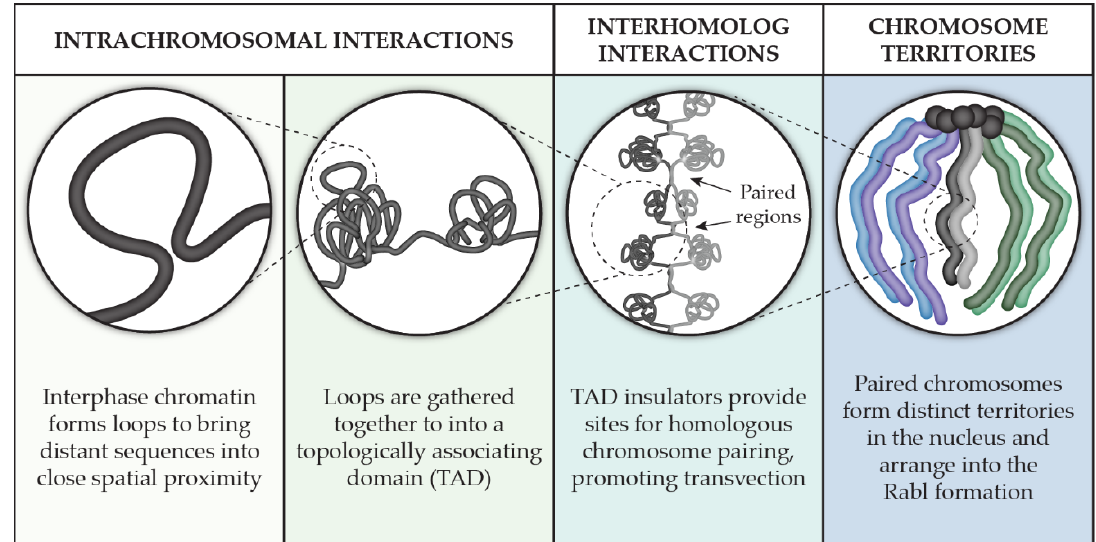
Figure 1. Genomic organization from the point of view of the chromosome.